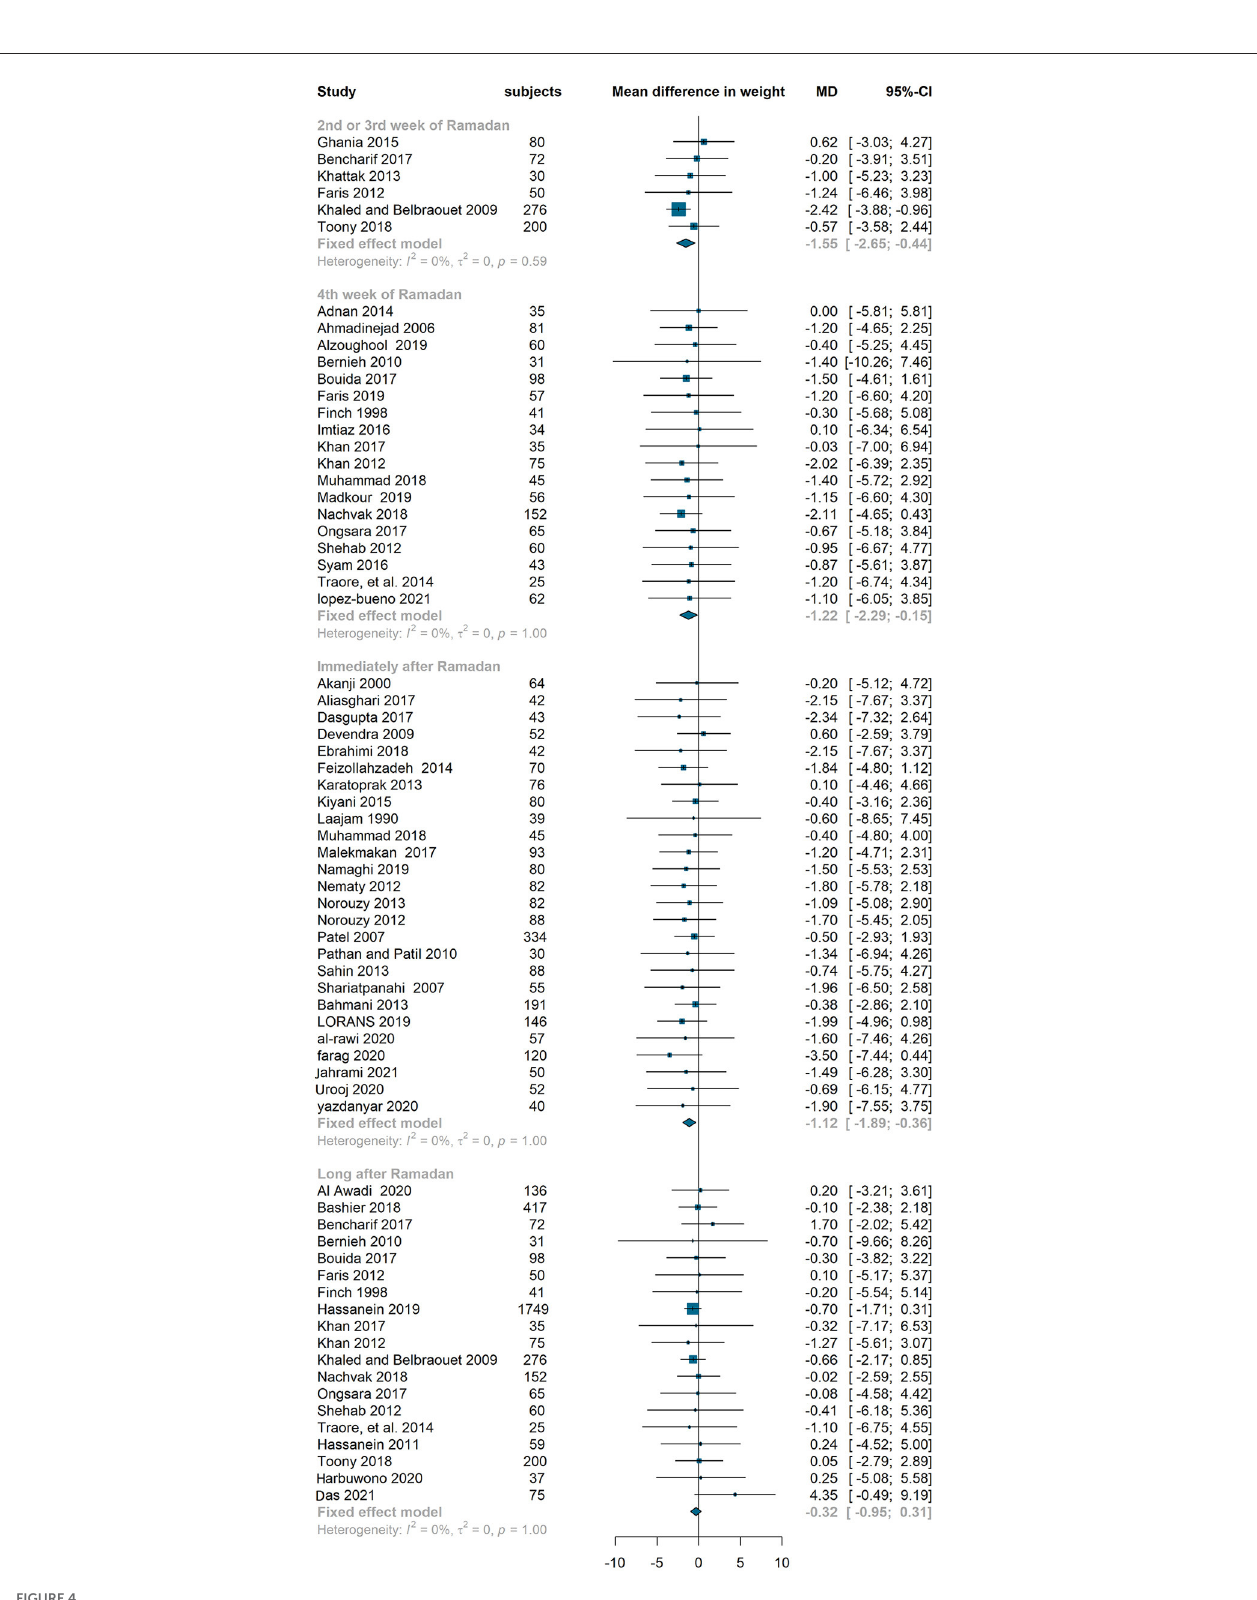
reduced in the other three models after 6 weeks. Furthermore, a systematic review and meta-analysis (24) compared the effect of RIF on anthropometric and body composition indices to that of